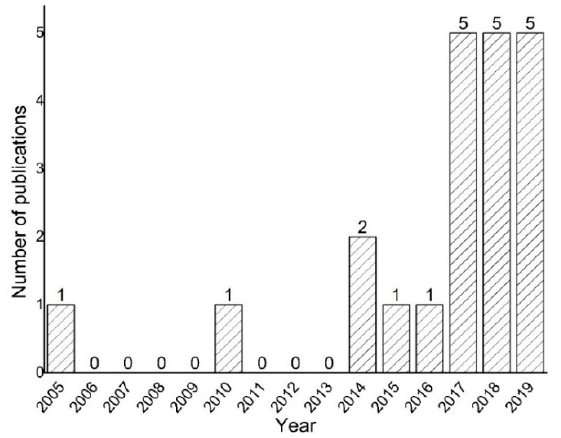
Figure 1. Publications on cactus mucilage for edible films and coatings.